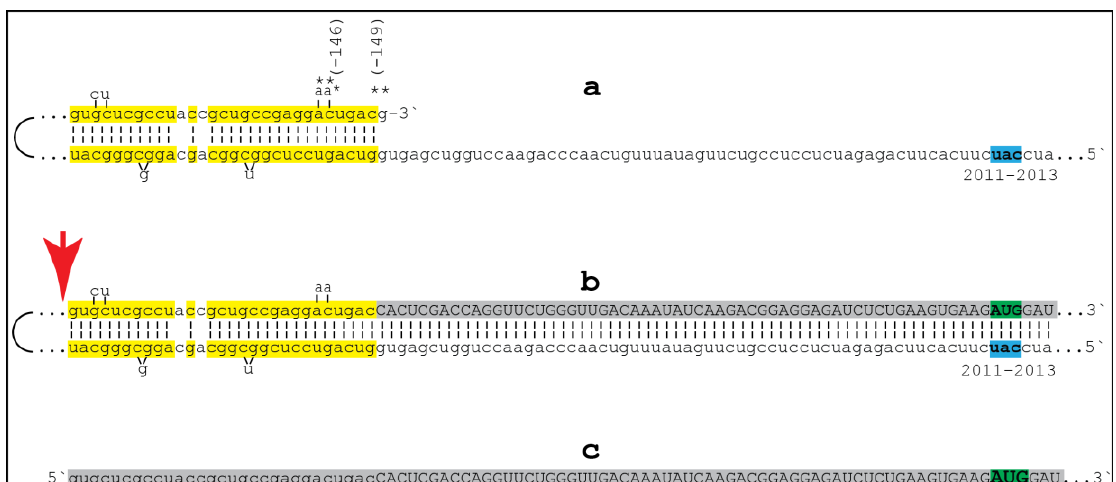
Figure 2. Projected topology of RdRp- mediated generation of 5′ - truncated human βAPP mRN A encoding C99 fragment of βAPP . Lowercase letters — nucleotide sequence of the antisense strand. Uppercase letters — nucleotide sequence of the sense RNA strand. Yellow boxes — TCE (top) and ICE (bottom) elements of the antisense strand. Asterisks, ( − 146) and ( − 149) — positions on the antisense strand corresponding to transcriptional start sites (TSSs) of human β APP mRNA (numbering from the AUG translation initiation codon of conventional mRNA ). “ 2011 – 2013 ”— positions on the antisense strand of the “uac” (highlighted in turquoise) corresponding to the “AUG” (highlighted in green) encoding Met671 (isoform 770 numbering) in the conventional β APP mRNA. (a) — TCE/ICE- guided folding of the antisense strand of β APP mRNA. Note that complementary elements are separated by nearly 2000 nucleotides. (b) — Extension of self-primed antisense strand into sense- orientation RNA and cleavage (after strands-separation) of chimeric intermediate . Note the “AUG” codon (highlighted in green and encoding Met671 in the conventional APP mRNA) 58 nucleotides downstream from the TCE. (c) — Chimeric end product contains, at its 5′ terminus, an antisense sequence (TCE, shown in lowercase letters) extending into severely 5′ -truncated β APP mRNA (shown in uppercase letters). Its translation is initiated from the AUG (highlighted in green) encoding Met 671 (isoform 770 numbering) in the conventional mRNA and it encodes C99 fragment of β APP.